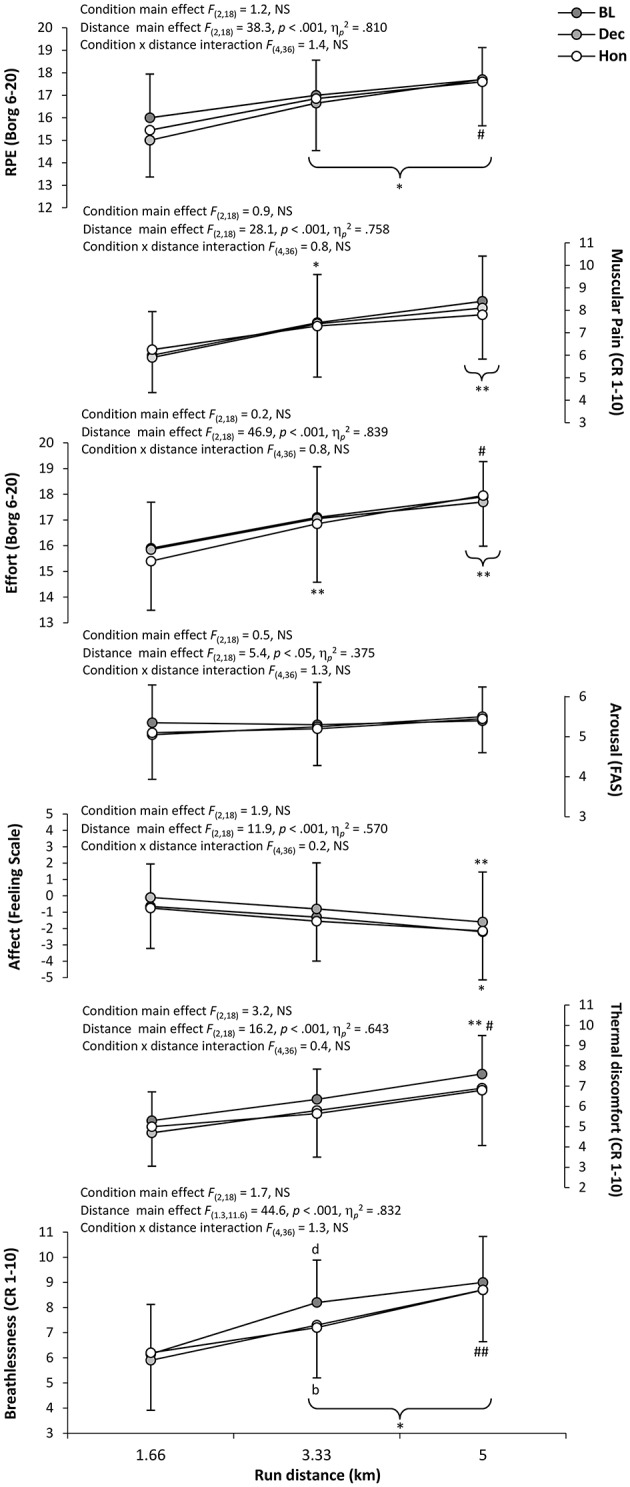
Mean ± SD perceptual responses for each 1.66 km run section. Significantly different from; BL, bp < 0.05; HON, dp < 0.05; initial value, *p < 0.05, **p < 0.01; previous value, #p < 0.05, ##p < 0.01 (parentheses indicate significance in all conditions).